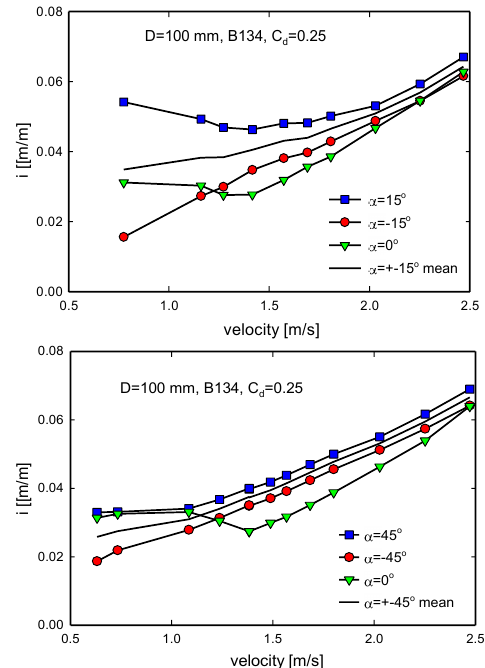
Fig. 4. Effect of the inclination angle α and flow velocity V on frictional pressure drops